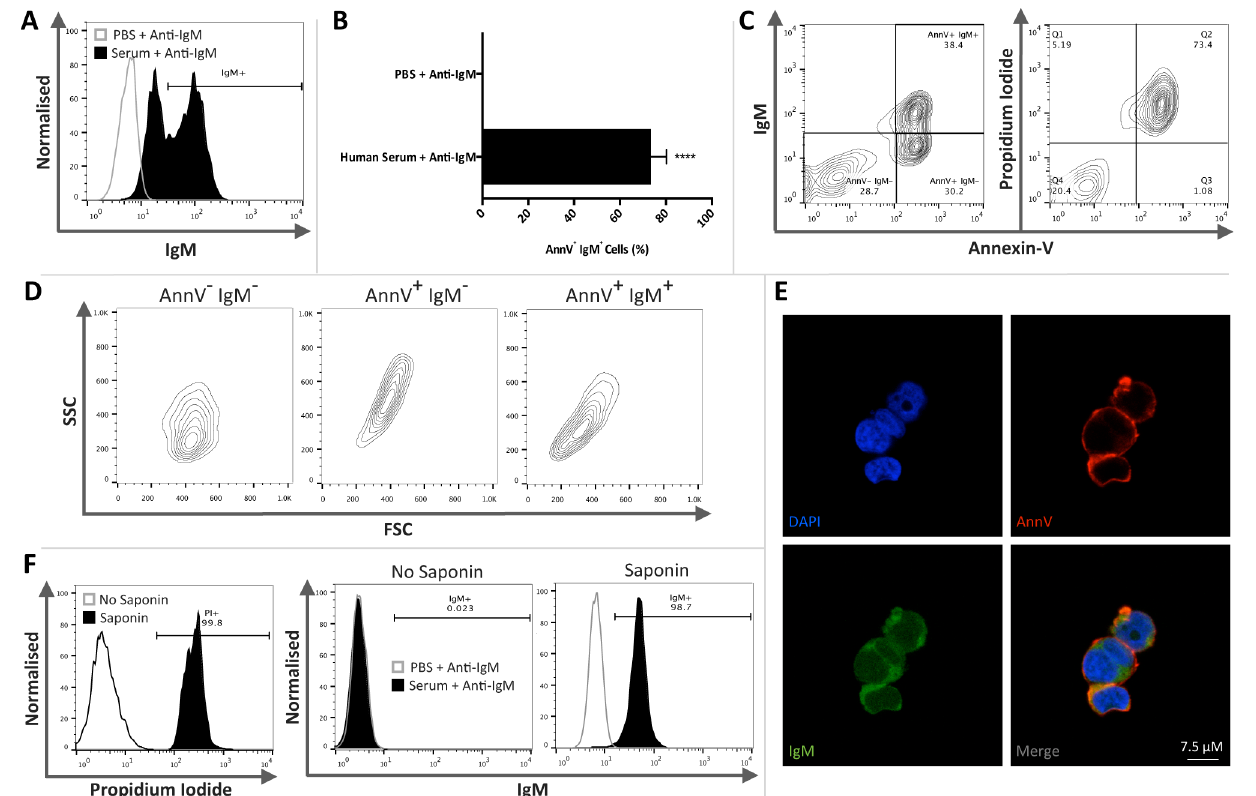
Fig 4. IgM binds AnnV + PI + and permeabilised human Jurkat cells. Human Jurkat cells were treated with camptothecin for 16-hours to induce apoptosis. Jurkat cells were then exposed to PBS or human serum as a source of IgM. IgM binding was then assessed by flow cytometry. Annexin-V (AnnV) and PI staining, assessed by flow cytometry, was used to determine the level of non-apoptotic (AnnV - PI - ), early (AnnV + PI - ) or late apoptotic (AnnV + PI + ) thymocytes. A ) Representative histogram illustrating IgM binding to AnnV + apoptotic Jurkat cells within human serum and PBS treatment groups. B ) Apoptotic Jurkat cells were gated on the basis of AnnV positivity and the percentage of AnnV + IgM + Jurkat cells was assessed. Apoptotic Jurkat cells exposed to human serum exhibited significant IgM binding. (Student ’ s t -test; P < 0.0001; n = 4) C ) Samples exposed to human plasma consisted of three distinct populations: AnnV - IgM - , AnnV + IgM - and AnnV + IgM + . Apoptotic Jurkat cells were largely AnnV + PI + . D ) The three distinct populations present in samples exposed to human serum were further characterised by examining FSC/SSC. Although both AnnV + IgM - and AnnV + IgM + populations were AnnV + PI + they occupy distinct separate regions of FSC/SSC contour plots. E ) Confocal microscopy revealed that late apoptotic Jurkat cells exhibited AnnV and IgM staining which appeared to be restricted to the membrane. F ) Non-apoptotic Jurkat cells were permeabilised with saponin prior to incubation with human serum. Permeability was confirmed by PI staining and IgM binding was assessed by flow cytometry. Following permeabilisation non-apoptotic Jurkat cells were predominantly PI positive. Non-permeable non-apoptotic Jurkat cells remained consistently IgM negative, whilst permeable Jurkat cells were IgM positive. Representative histograms and contour plots ( n = 3 per group). Images were taken using a Leica SP5 with an x63/1.4 objective. Whole image contrast/ brightness was adjusted using ImageJ or Adobe Photoshop. Data expressed as means ±